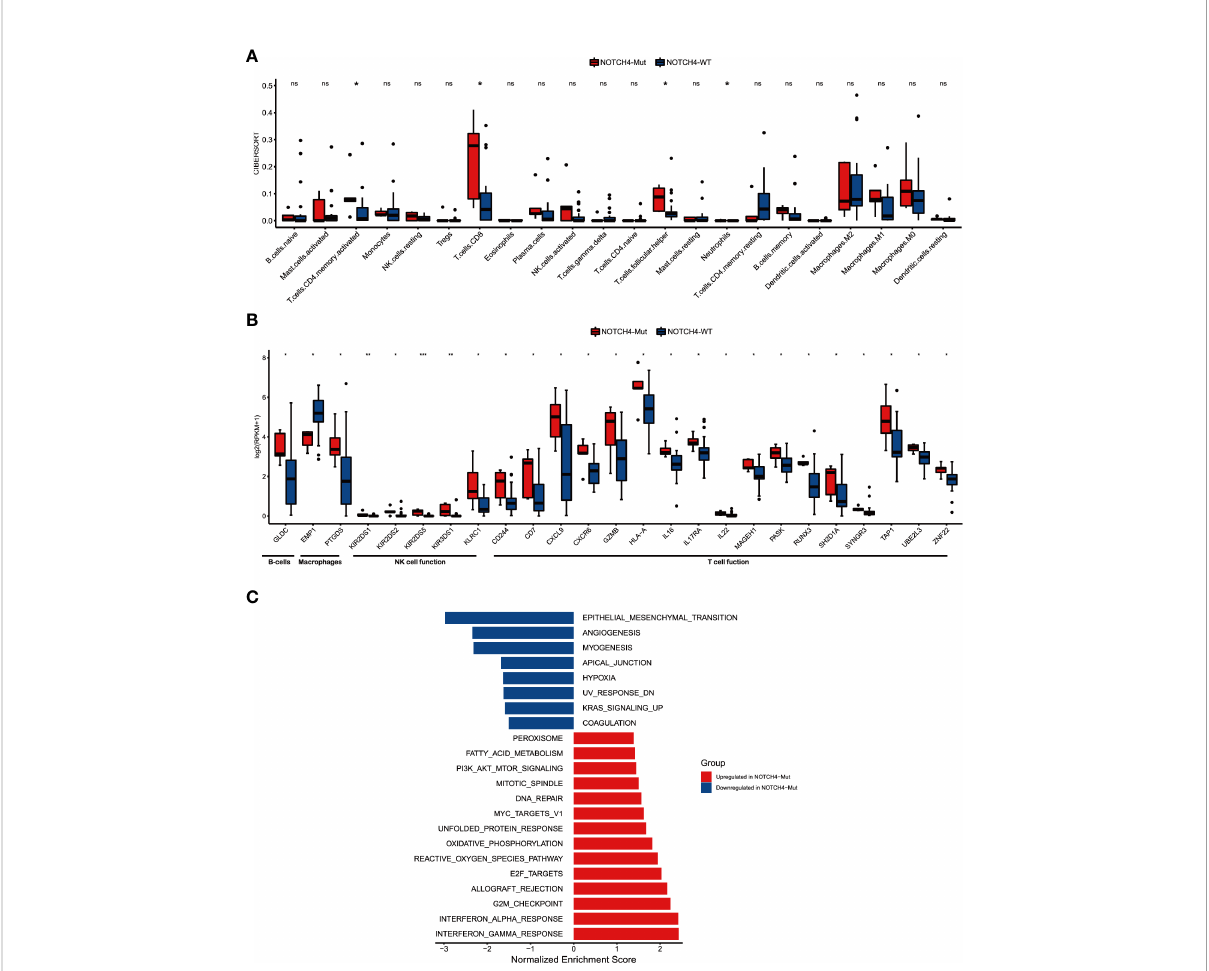
FIGURE 5 NOTCH4-Mut was associated with enhanced anti-tumor immunity. (A) Boxplot depicting the in fi ltration of 22 immune cells in NOTCH4-Mut and NOTCH4-Wt tumors. Gene expression pro fi les were uploaded to the CIBERSORT web portal, and the algorithm was con fi gured with 1,000 permutations. (B) Box plot of gene expression of immune-related genes in comparison of NOTCH4-Mut and NOTCH4-Wt patients. (C) Differences in pathway activities scored by GSEA Hallmark collection between NOTCH4-Mut and NOTCH4-Wt tumors. Enrichment results with signi fi cant associations between NOTCH4-Mut and NOTCH4-Wt tumors are shown ( P < 0.05, FDR <0.05). The blue bar indicates that the normalized enrichment score (NES) of the pathway is less than 0, while the red bar indicates that the NES of the pathway is more than 0. Notes: *P < 0.05; **P < 0.01; ***P < 0.001; ns, P >